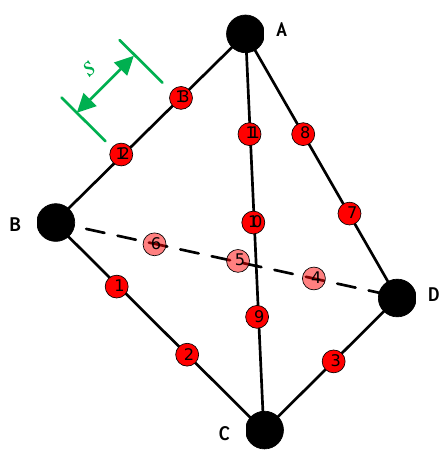
Figure 3. Two categories of nodes on the model. The black circle and the red circle represent the first category node and the second category node, respectively.